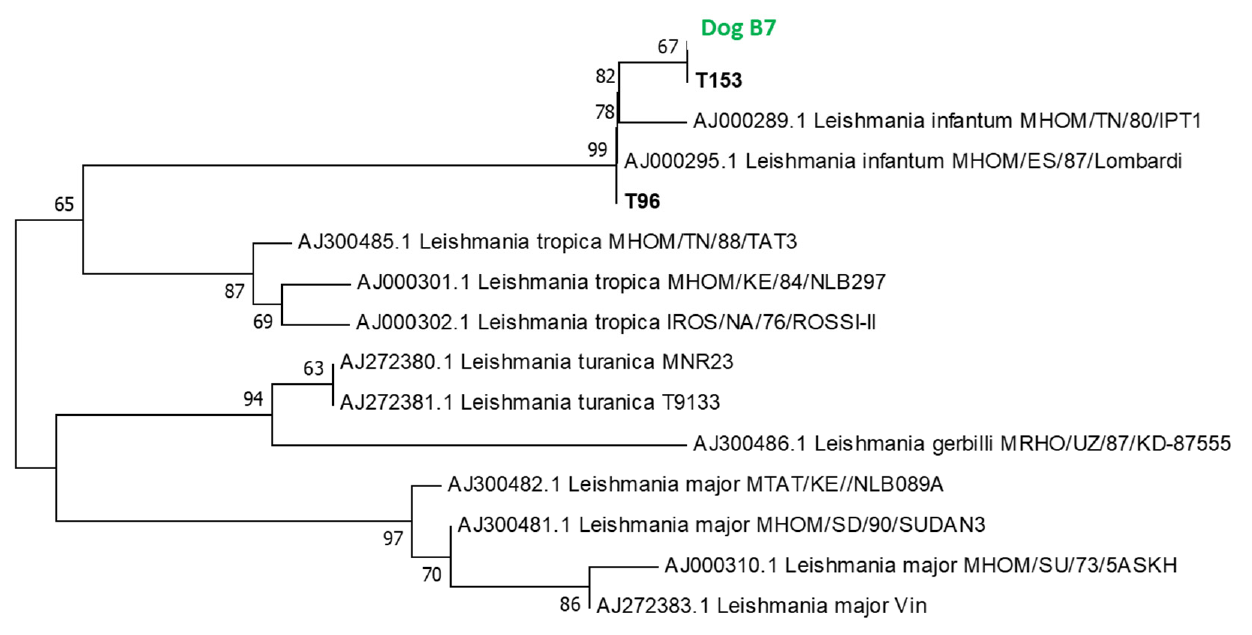
Figure 2. Phylogenetic tree based on partial Leishmania ITS-rDNA 5.8 s sequences.